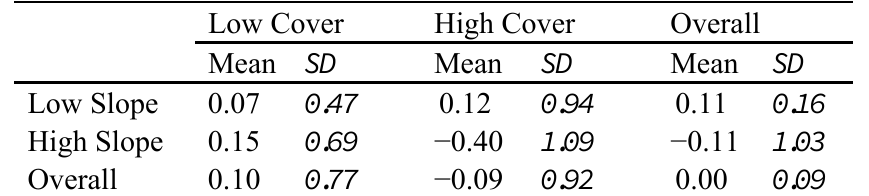
Table 4. Mean and standard deviation for signed slope error (%) for road segments in four slope and canopy cover